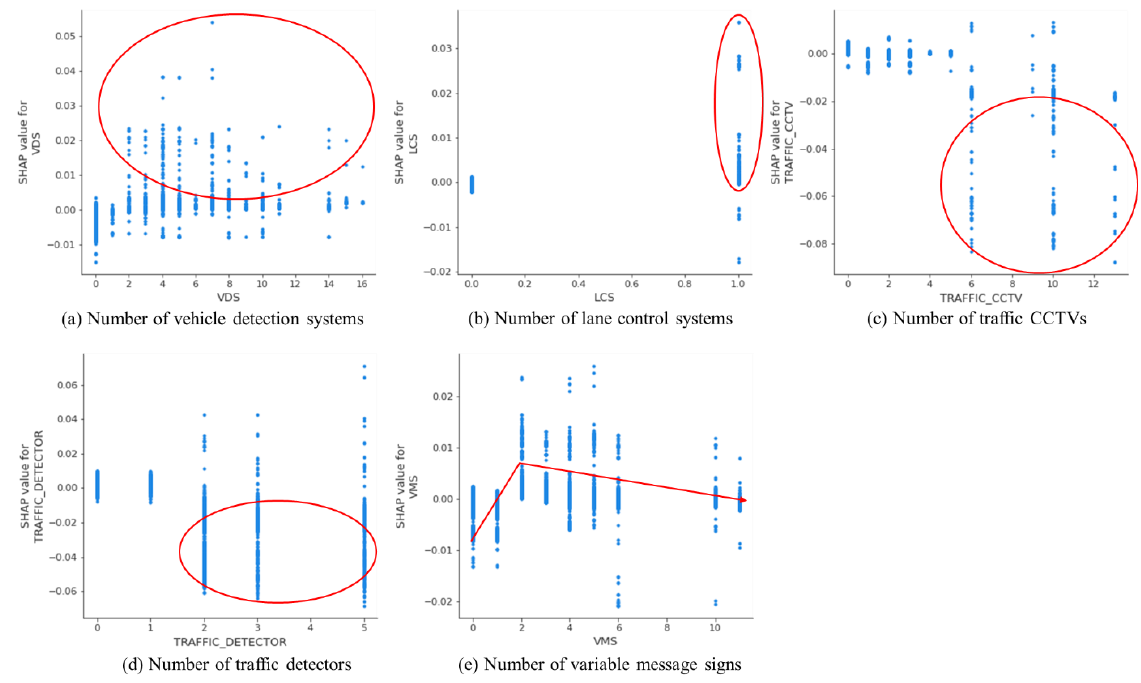
Figure 15. Dependence plots for features with less clear patterns related to smart transportation systems.